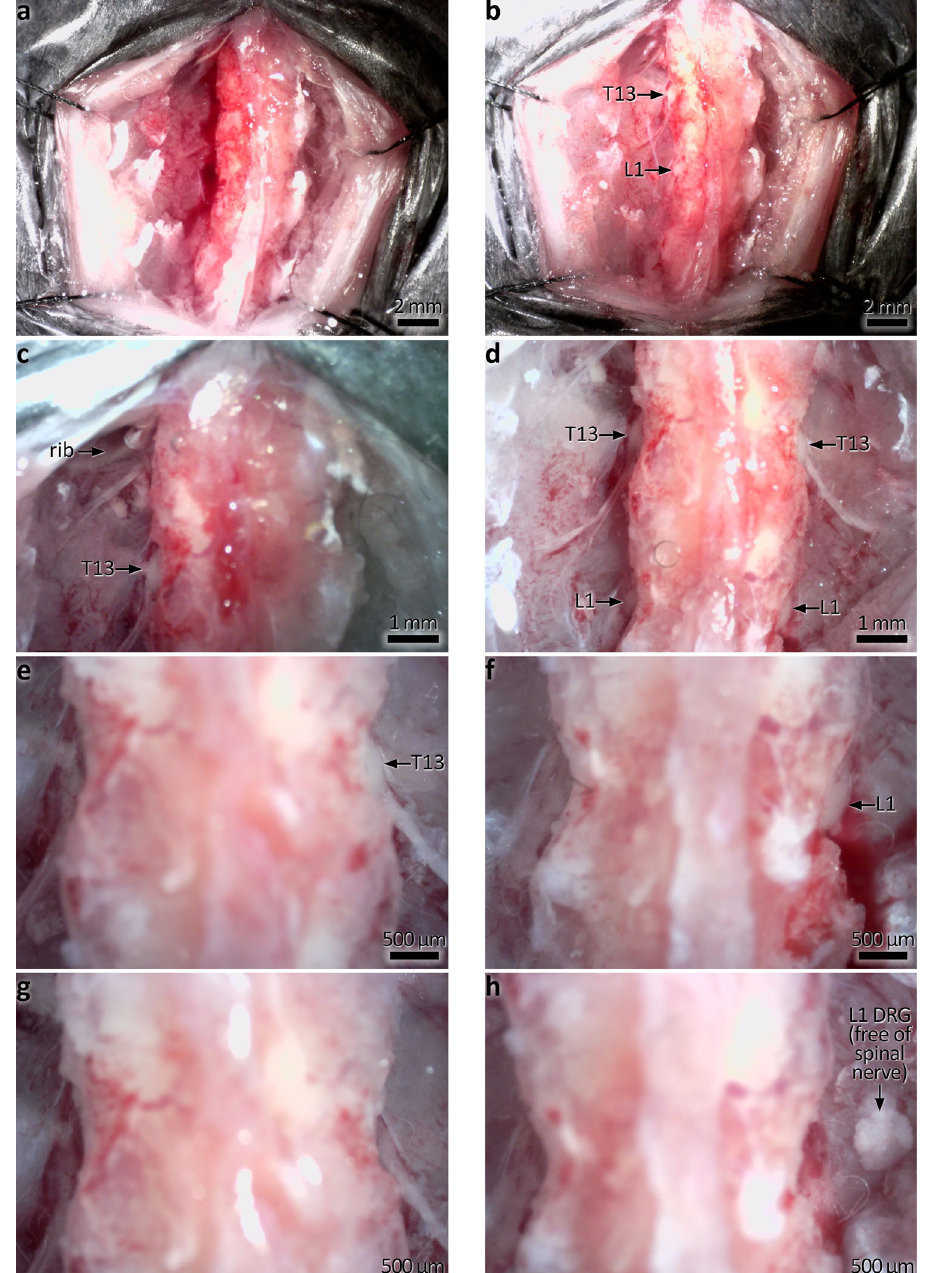
Fig. 4 In vivo photographs showing DRG removal at T13-L1. a The dorsal skin and musculature is cut either side of the spine. The most inferior ribs are used as a landmark; T13 DRG are located just inferior to the ribs. b Exposure of T13 and L1 DRG on the left side following partial removal of the vertebrae. Here the spinal nerves can be seen emerging from the DRG, which may be used as a guide before exposure. c Higher magni fi cation, showing T13 DRG. The rib location is also indicated. d Bilateral exposure of T13 and L1 DRG. Prominent spinal nerves emerge from T13. e , f Unilateral removal of T13 and L1 DRG. g , h Bilateral removal of T13 and L1 DRG. Note the right L1 DRG shown fl oating free after removal (indicated by